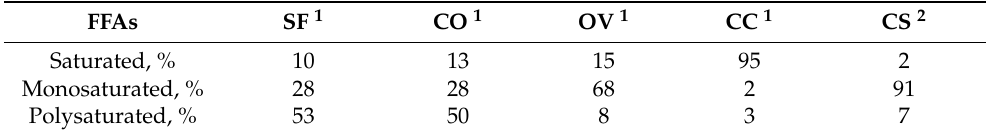
Table 1. Bibliographic information on the fatty acid composition of selected oils. FFAs SF 1 CO 1 OV 1 CC 1 CS 2 Saturated, % 10 13 15 95 2 Monosaturated, % 28 28 68 2 91 Polysaturated, % 53